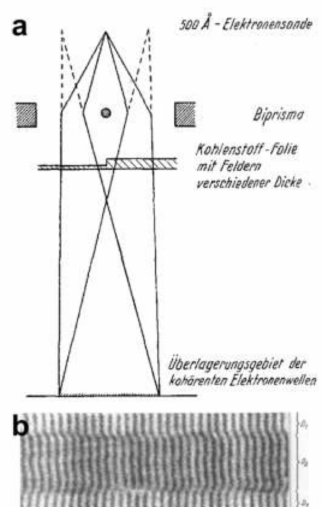
Figure 12. O ff -axis electron holography. ( a ) Experimental arrangement. ( b ) O ff -axis electron hologram exhibiting the shift in the interference pattern caused by the di ff erent thicknesses of the sample, and therefore by the di ff erences in potential and the additional phase shift. Reprinted from [40] by permission from Springer Nature, copyright